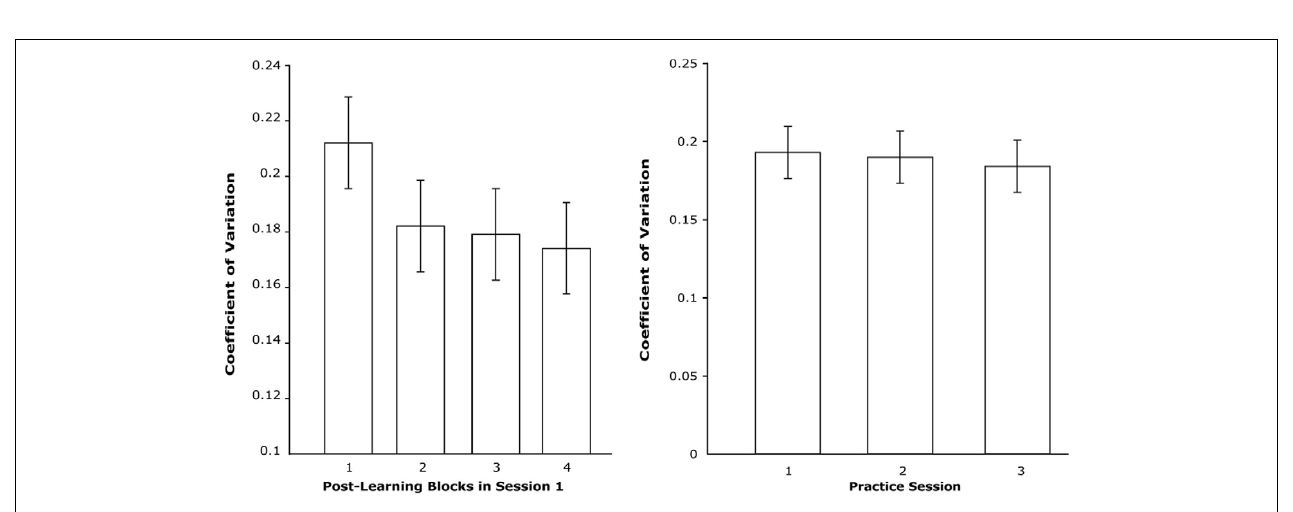
FIGURE 3 | Left: CV across four blocks of post-learned trials in session 1. Right: CV of post-learned trials across first three sessions.